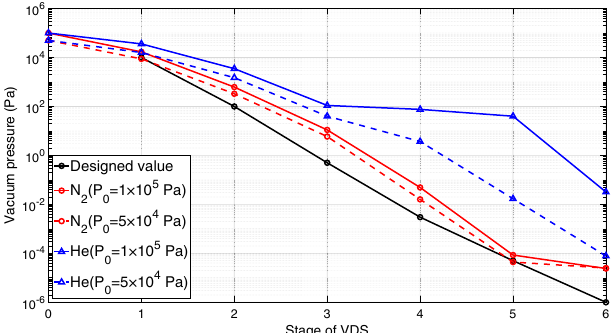
FIG. 20. Vacuum comparison with different initial pressure and gas in VDS. (Nitrogen gas: from 1 × 10 5 Pa to 2 . 4 × 10 − 5 Pa, Helium gas: from 8 × 10 4 Pa to 7 . 8 × 10 − 5